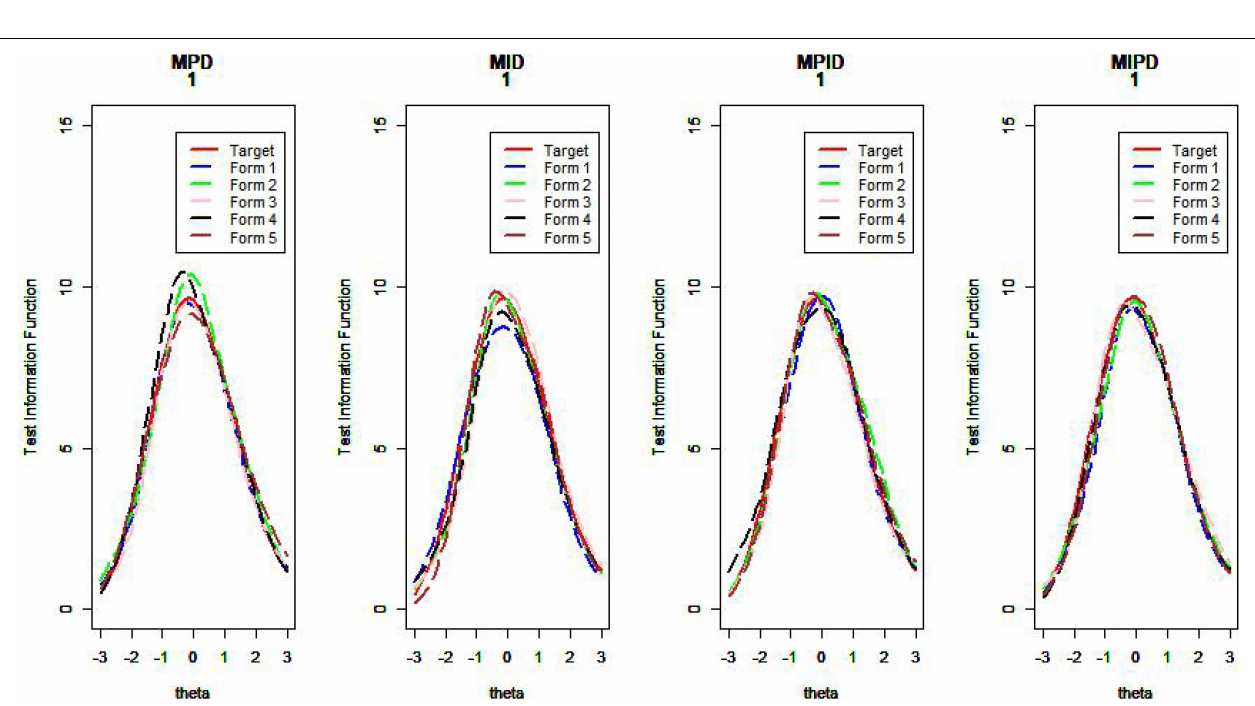
FIGURE 11 | Test information curve ( D =